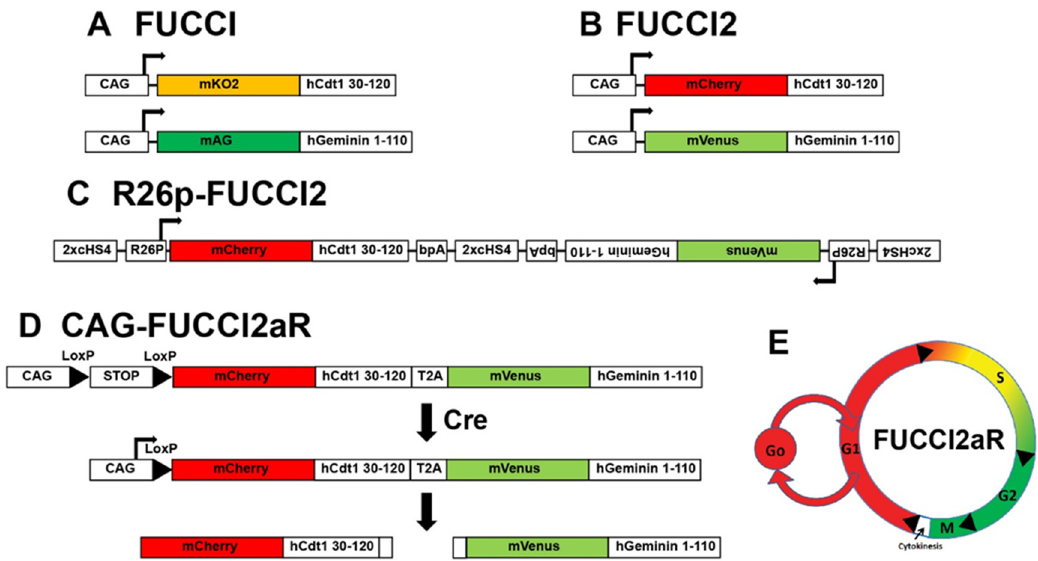
Figure 3. Fluorescent Ubiquitination-based Cell Cycle Indicator (FUCCI) reporters. First-generation FUCCI ( A ) and FUCCI2 ( B ). Second-generation Bidirectional R26p-FUCCI2 ( C ) and polycistronic FUCCI2aR ( D ). ( E ) Schematic of cell cycle phase-dependent differential expression of FUCCIs.